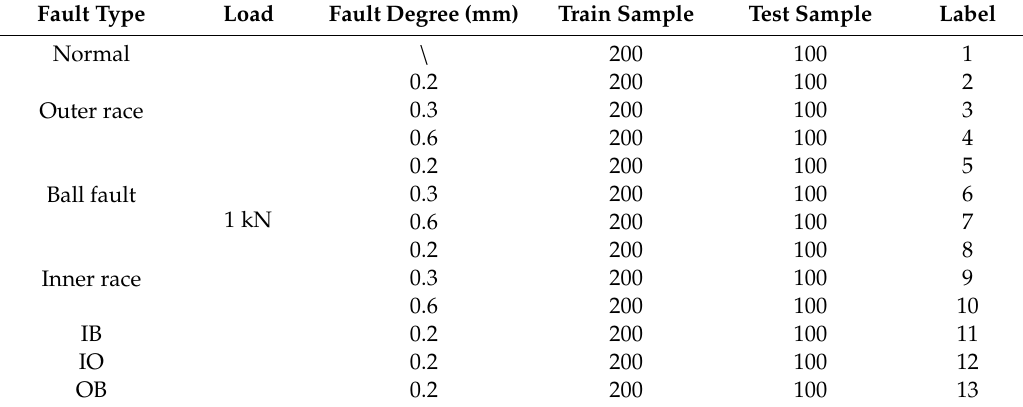
Table 4. Description of compound faults for